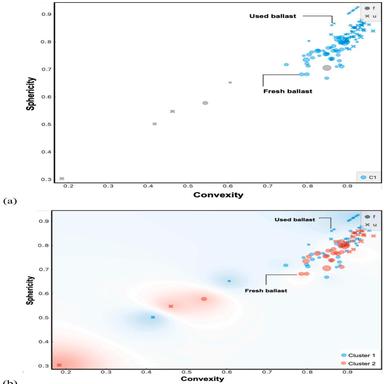
Unsupervised machine learning with Orange software: (a) DBSCAN, and (b) K-mean. (For interpretation of the references to color in this figure legend, the reader is referred to the web version of this article.)